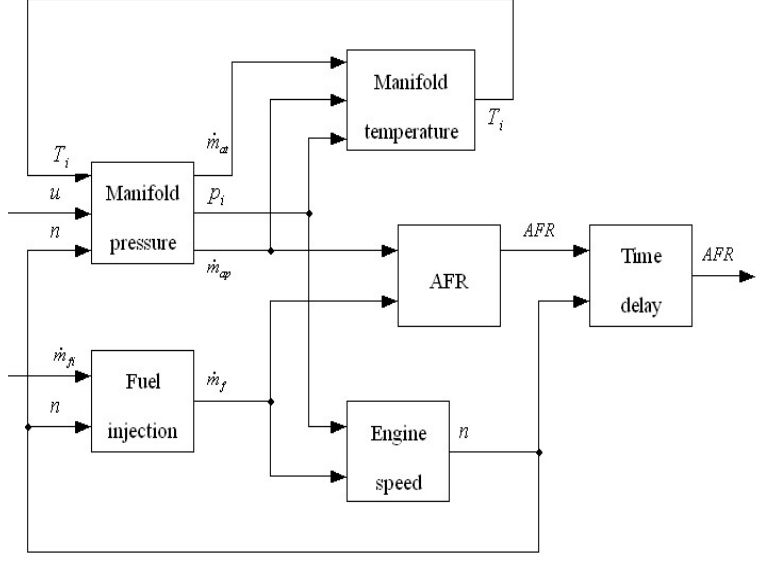
Figure 1. Expanded mean value engine model (MVEM). AFR: air/fuel ratio.